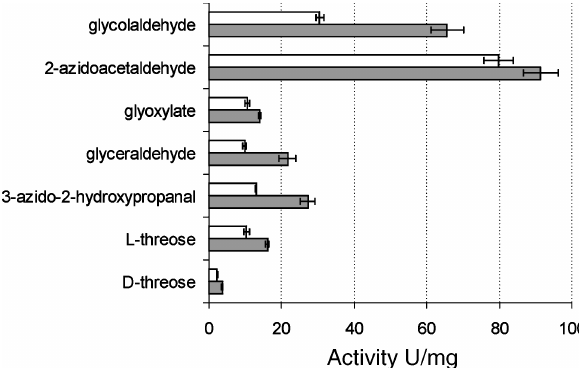
Figure 4. Activity of purified SacKdgA (white bars) and SacKdgA- V193A (gray bars) on different (unnatural) aldehyde substrates at 50 °C. Activities were determined in 50 mM sodium phosphate buffer (pH 6.0), 50 mM pyruvate and 100 mM